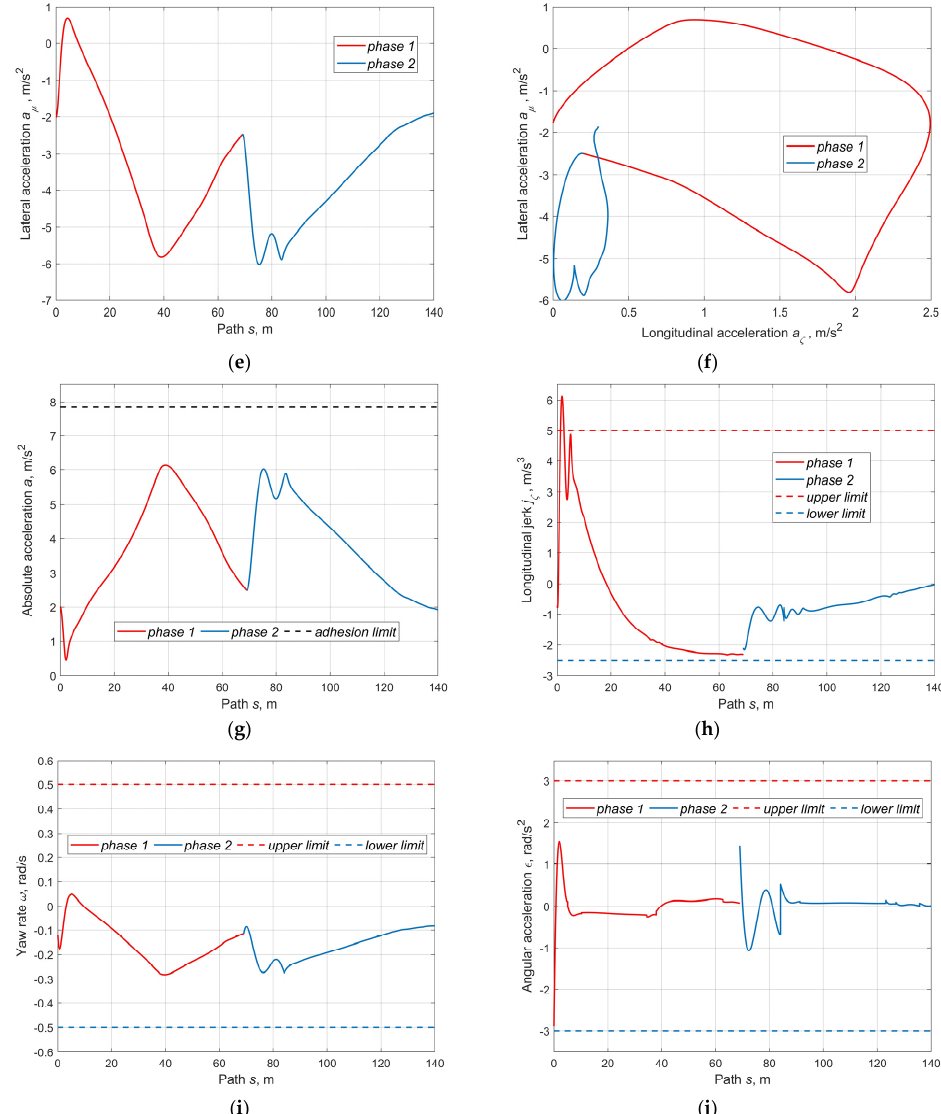
Figure 8. Optimized kinematic parameters along the predicted path by phases: ( a )—speed; ( b )—critical slip speed; ( c )—longitudinal acceleration; ( d )—longitudinal acceleration over speed; ( e )—lateral acceleration; ( f )—lateral over longitudinal acceleration; ( g )—absolute acceleration; ( h )—longitudinal jerk; ( i )—yaw rate; ( j )—angular acceleration.